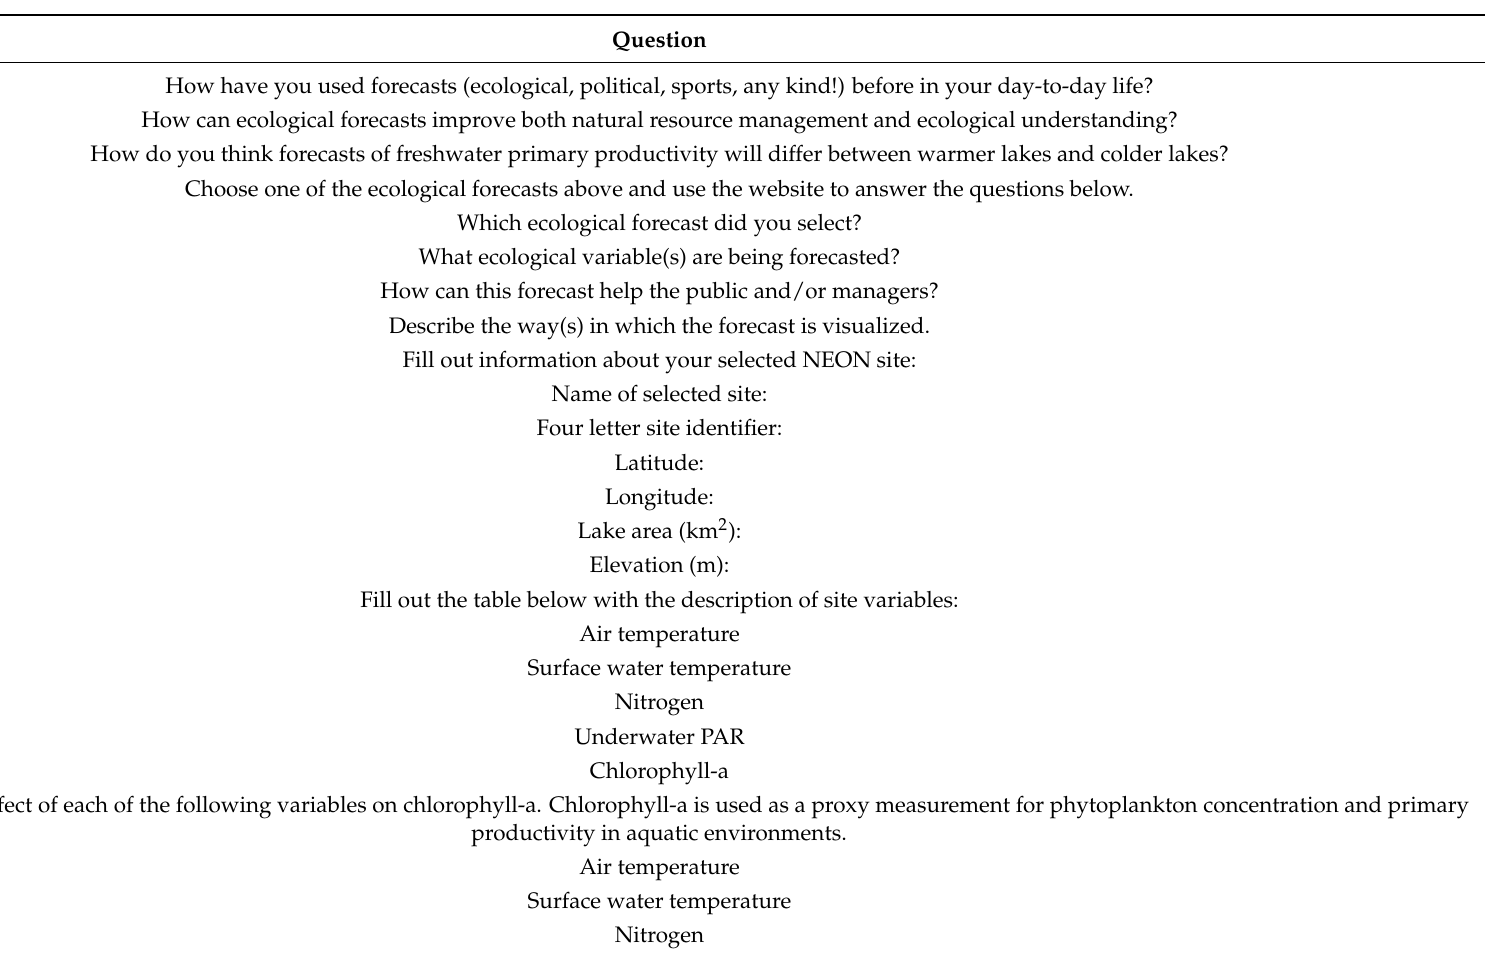
Table A1. Short-answer questions which are embedded in the interactive online tool which the student must complete as they complete each of the different objectives within the